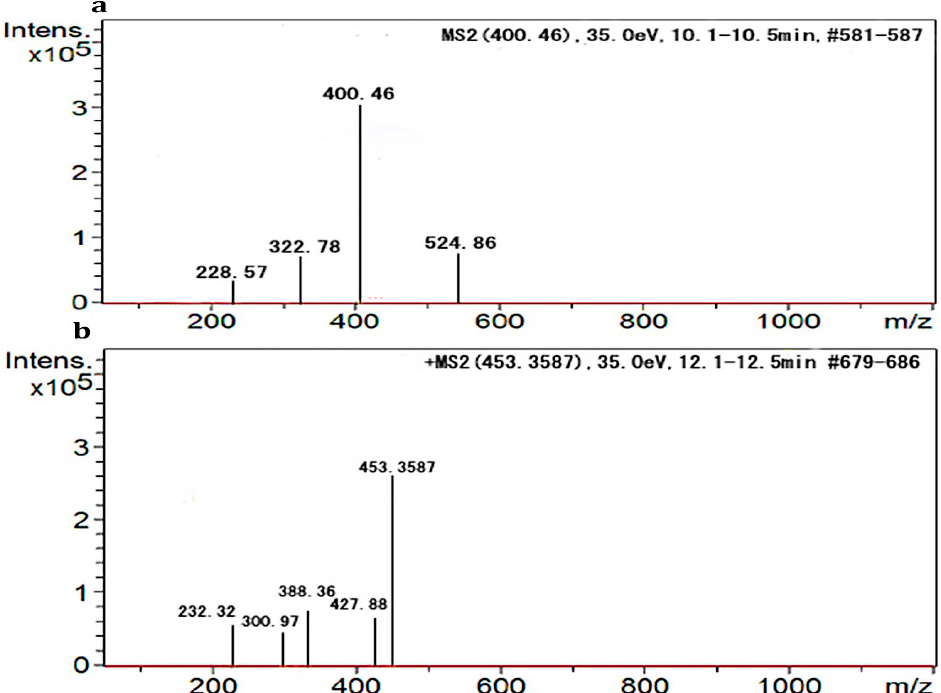
Figure 5. Electron spray ionization Mass spectroscopy (ESI-MS) spectrum of Penicillium chrysogenum (CAL1) purified siderophore ( a ) iron-free siderophore, ( b ) iron-containing siderophore.